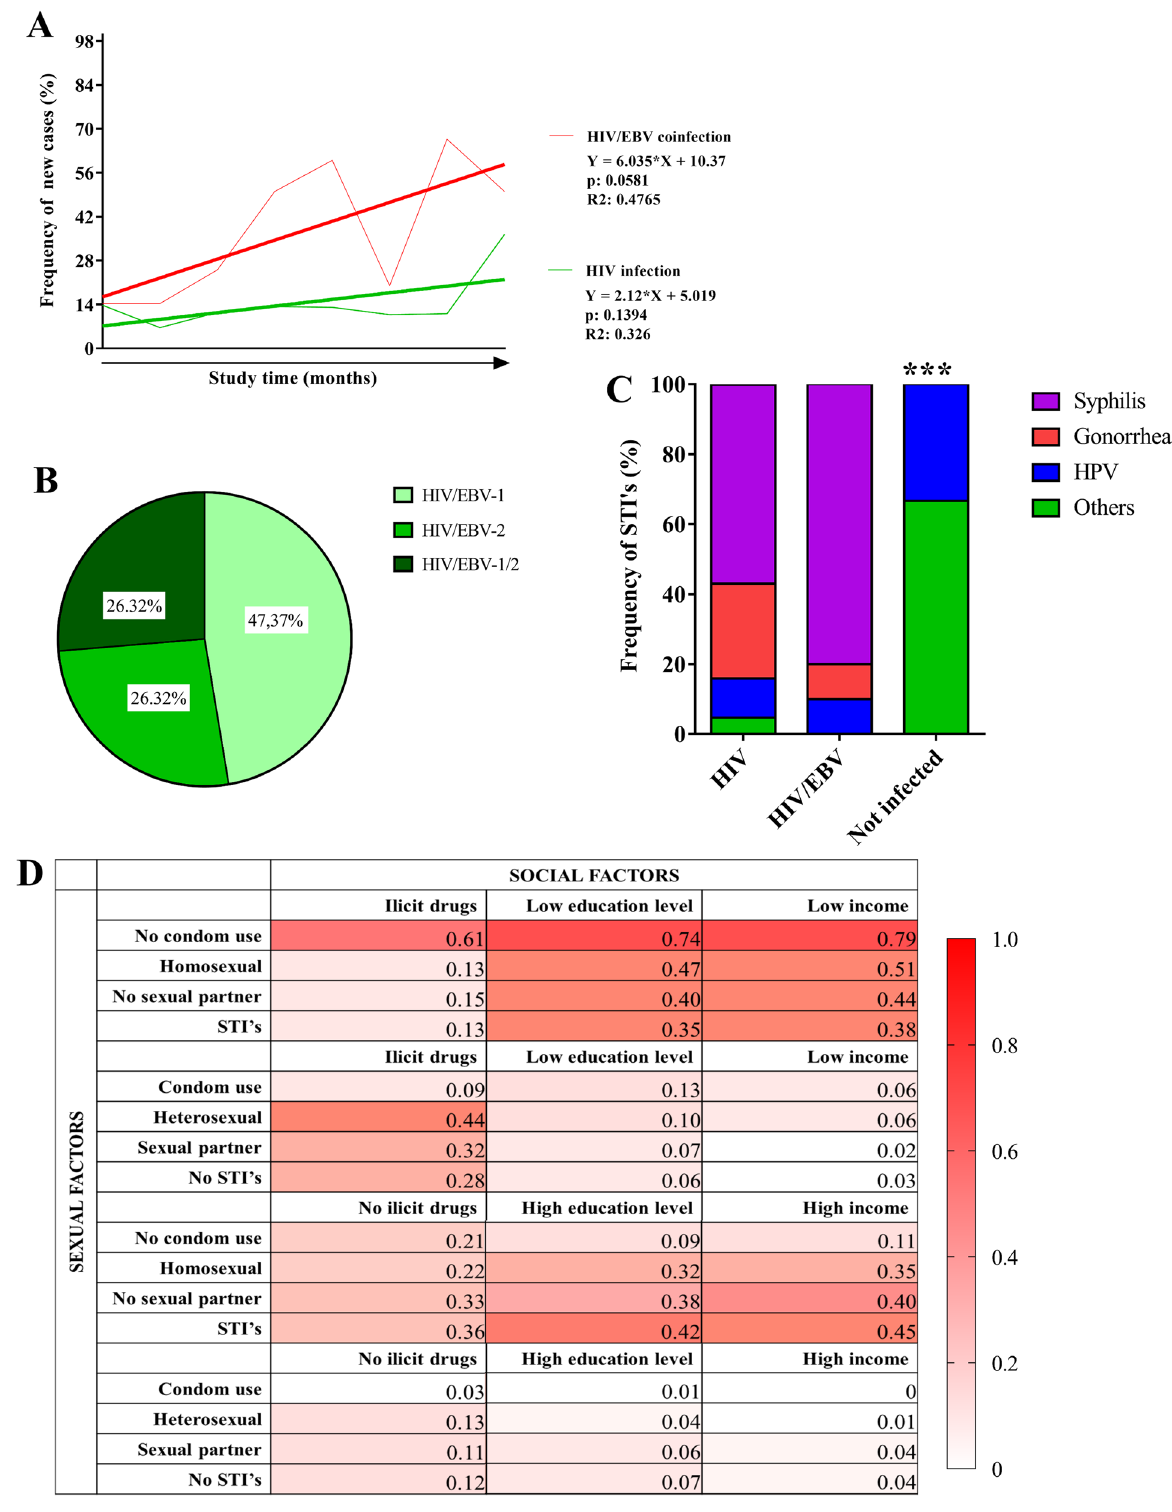
Figure 1. Frequency of cases and degree of exposure: ( A ) Frequency of new cases of HAART-free HIV-1 patients coinfected with HIV/EBV in the period between January 2018 and December 2019. ( B ) Prevalence of cases of HIV/EBV coinfection stratified based on age and sex. ( C ) Prevalence of EBV genotypes among HIV/EBV coinfected patients. ( D ) Potential risk/exposure to HIV-1 monoinfection or co-infection. The color gradient was proposed based on data on the frequency of individuals screened according to the intersection of social and sexual